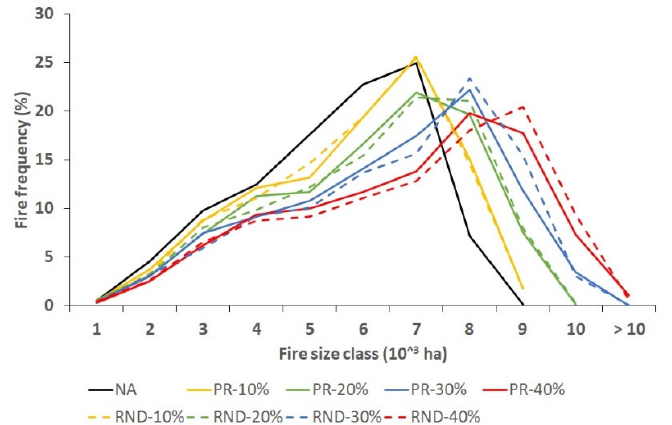
Figure 8. Frequency distribution of the different FS values simulated for the NA and two spatial patterns of land abandonment scenarios (priority, PR, and random, RND), considering 10, 20, 30, and 40% of agropastoral land abandonment.